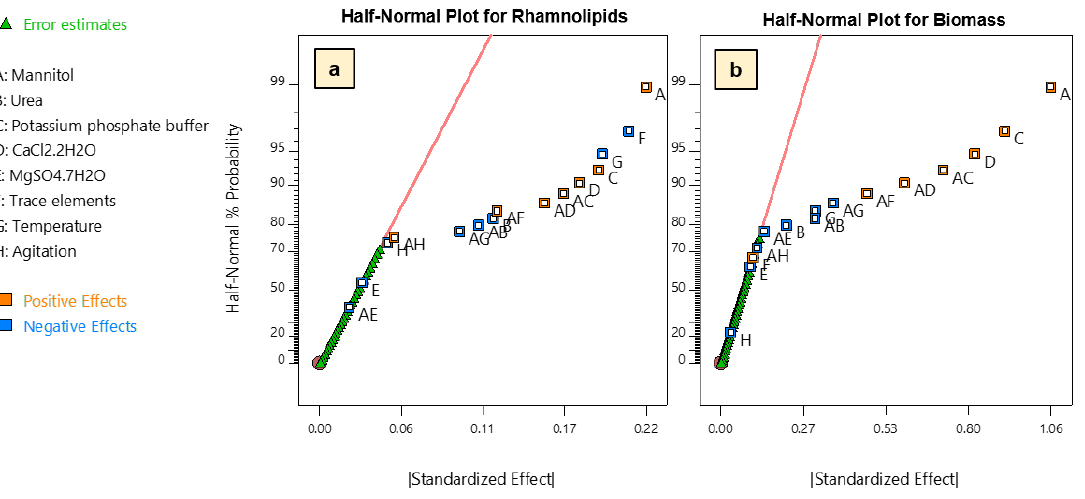
Figure 2. Half-Normal probability plot of main and two-way interaction effects on: ( a ) rhamnolipid production; and ( b ) biomass (dry weight) obtained from FFD. Two-way interaction effects between variables are indicated by listing the involved variables. For example, AB indicates a two-way interaction effect between A and